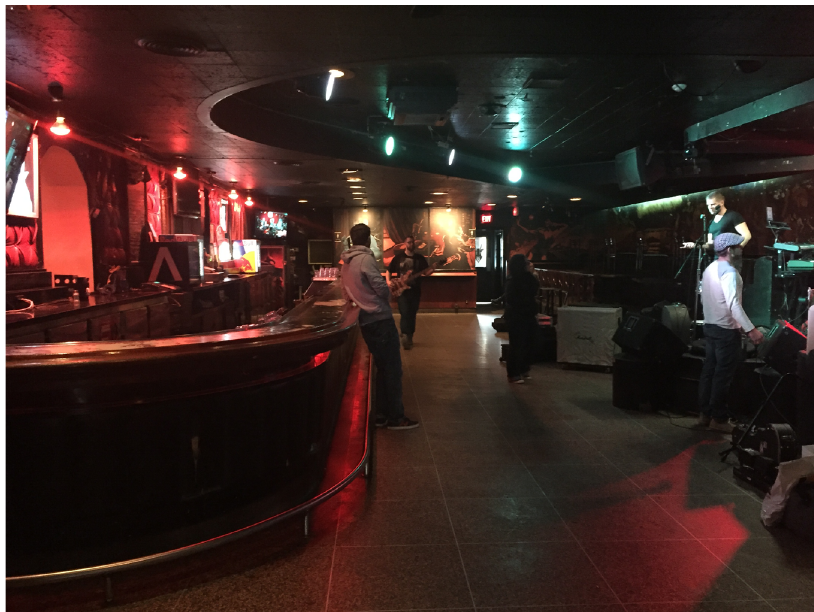
Figure 5. Interior of the Silver Dollar Room viewed from the entrance side of the space. The bar area is to the left, and the stage is to the right. In this photo a band is setting up its performance space for later that